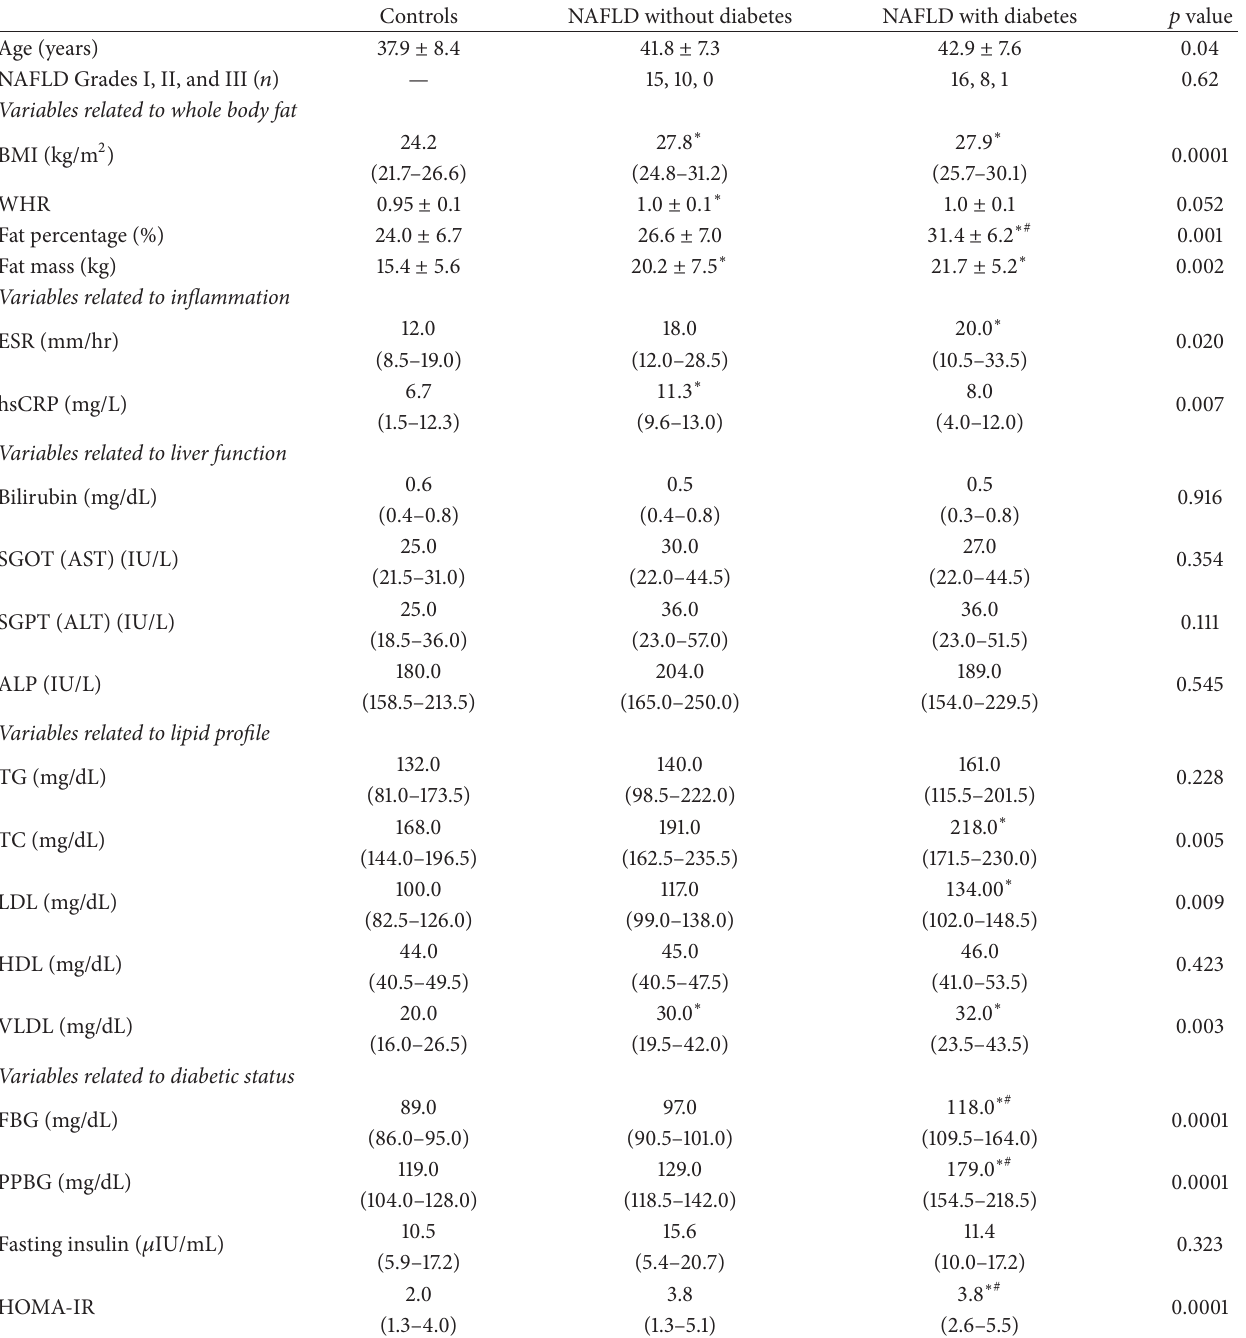
Table 1: General, anthropometric, and biochemical parameters of the